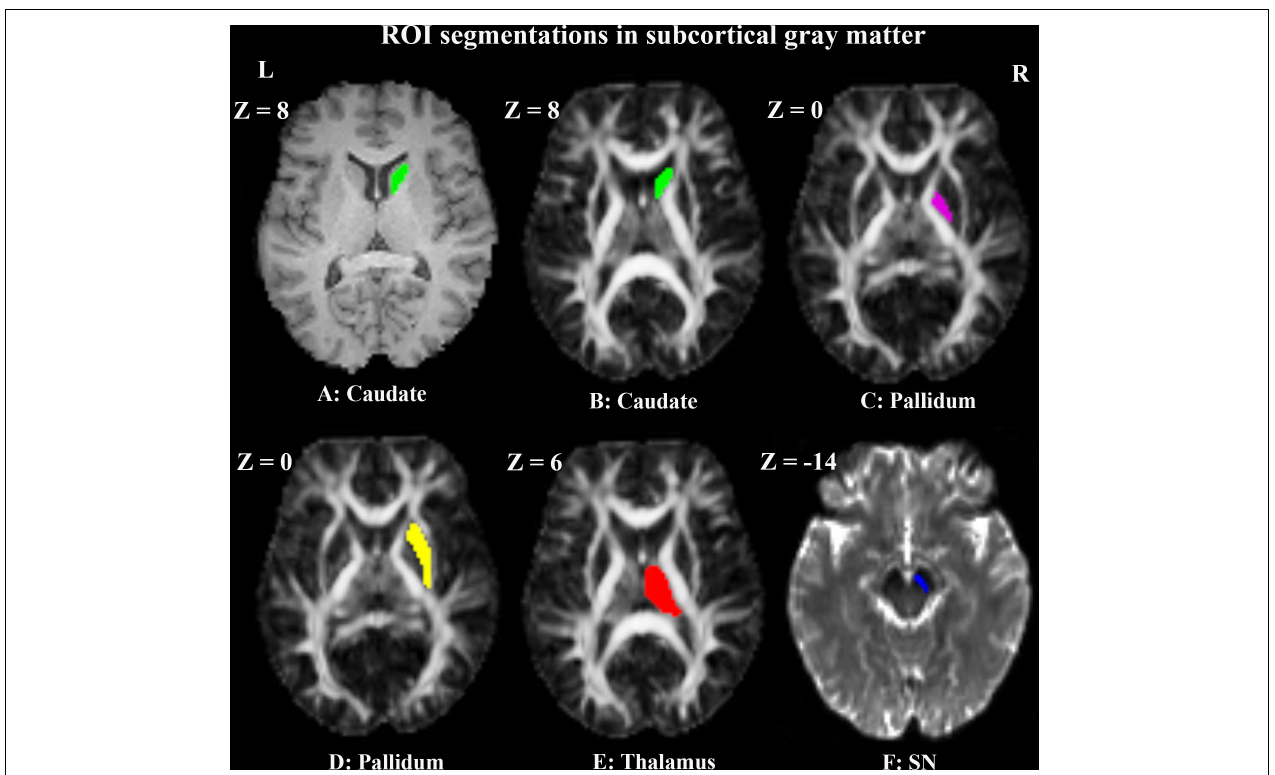
FIGURE 2 | Example of manual ROI segmentations in the right subcortical gray matter of a representative PD patient. The ROI of the right caudate is shown in green on T1WI (A) and FA map (B) . The ROIs of right pallidum (C) , putamen (D) , and thalamus (E) are shown in violet, yellow and red on FA maps, respectively. The ROI of right SN (F) is shown in blue on the b0